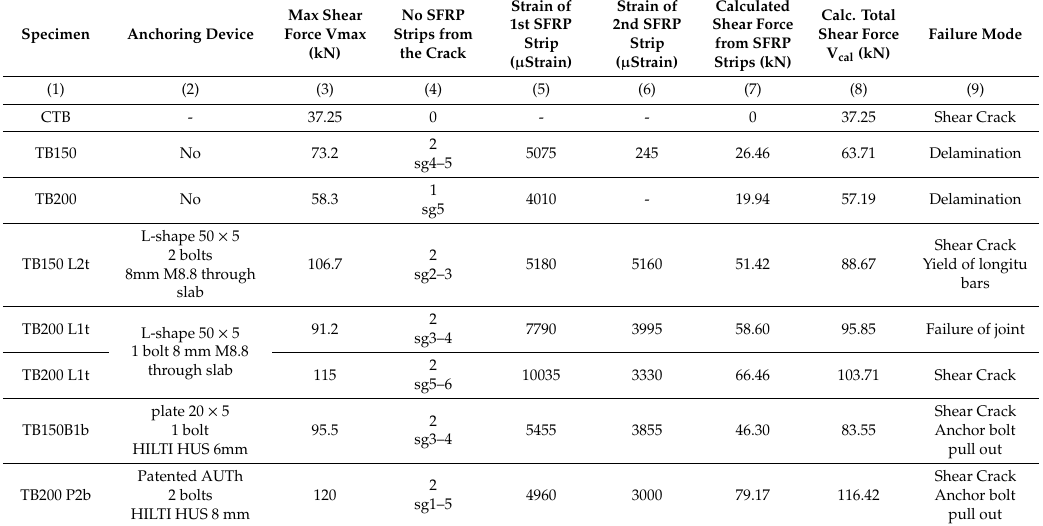
Table 2. Experimental